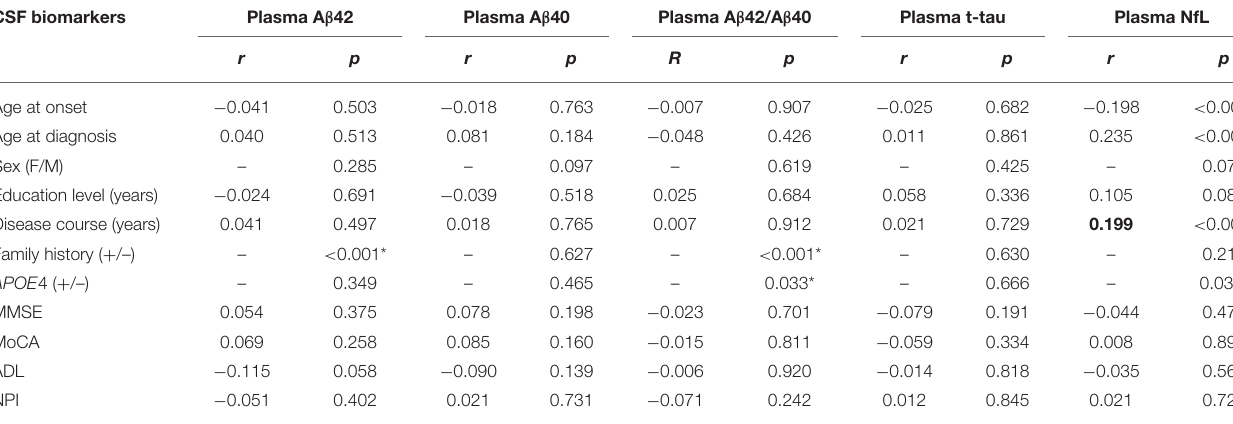
TABLE 2 | Correlations of plasma biomarkers with demographics and neuropsychological assessments in patients with AD. CSF biomarkers